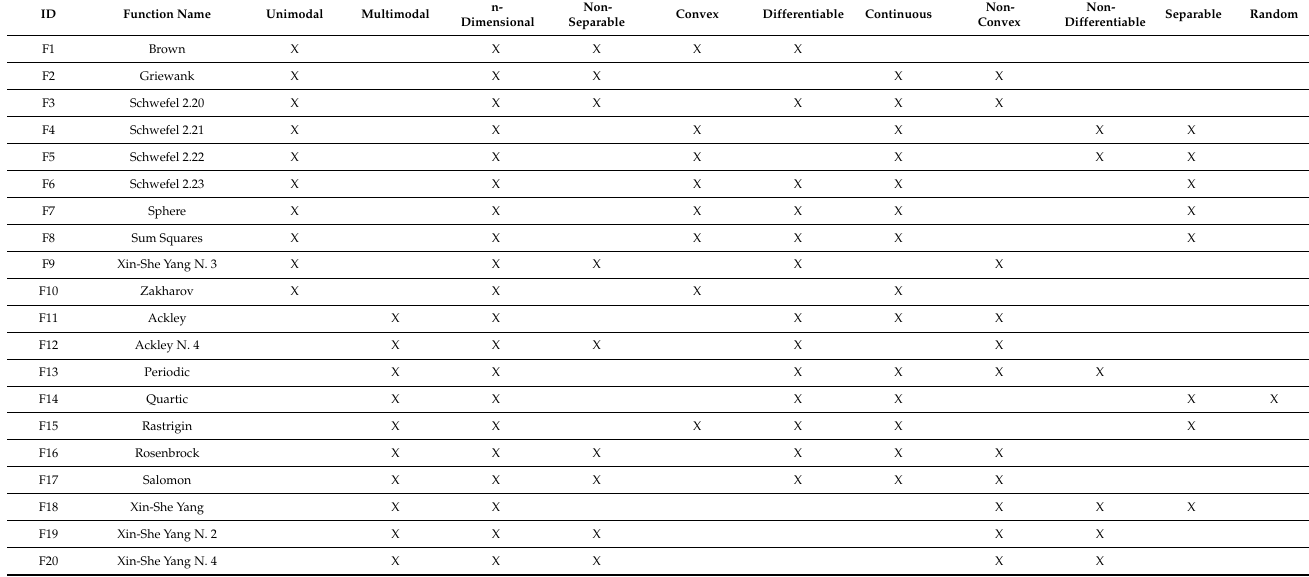
Table A1. Classification of Testbench functions. Convex Differentiable Continuous Non- Convex Non- Differentiable Separable